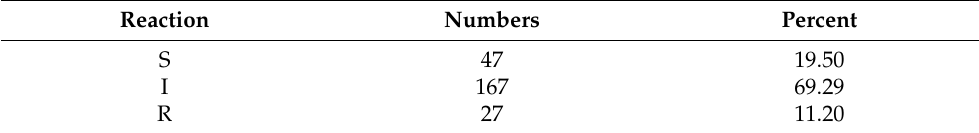
Table 2. Analysis of resistance identification for G. soja accessions.